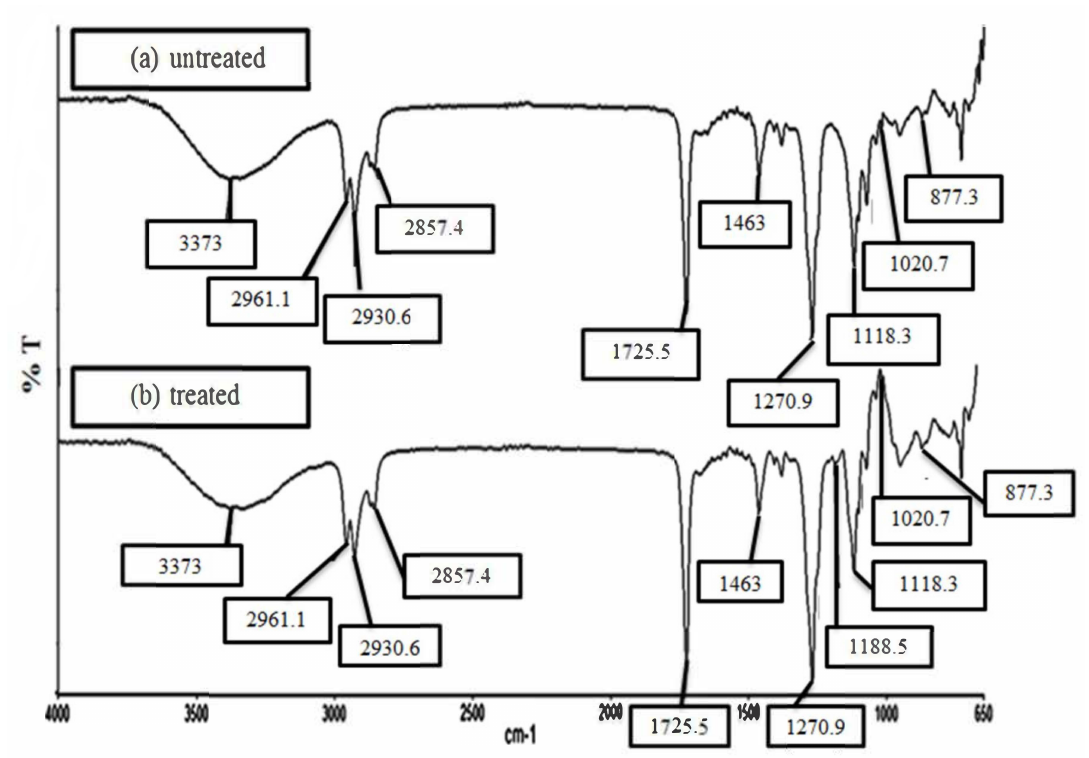
Figure 8. FTIR spectra of ( a ) untreated and ( b ) treated RC EFB biocomposite films with